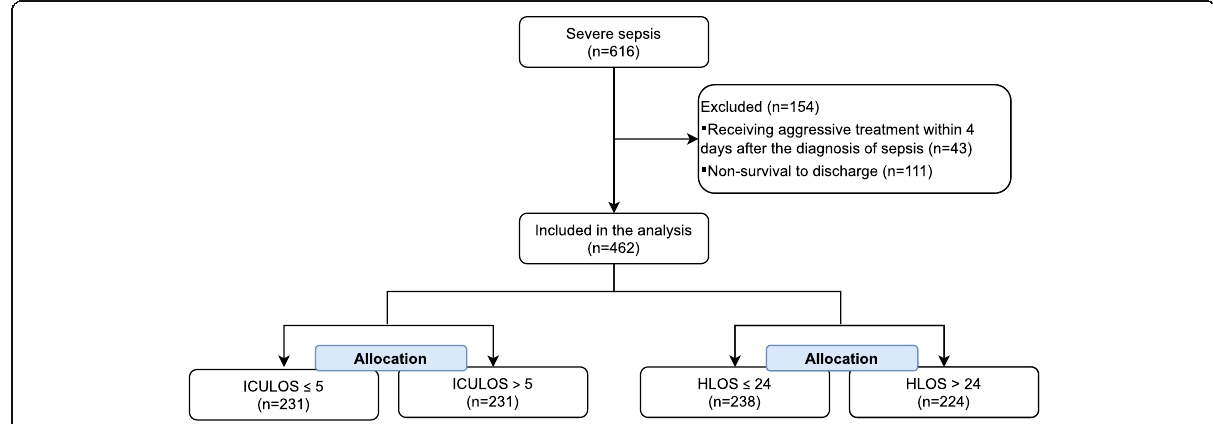
Fig. 1 The flow chart of the study: patients included in the study and their division into